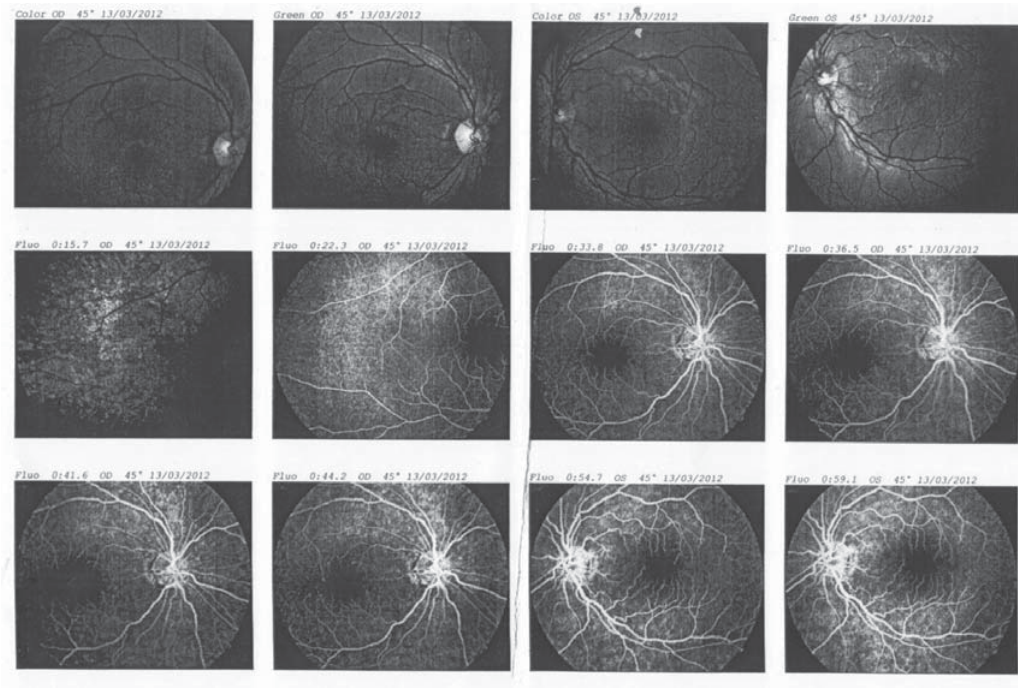
FIGURE 3. Bilateral profound optic atrophy with empty, pale discs on